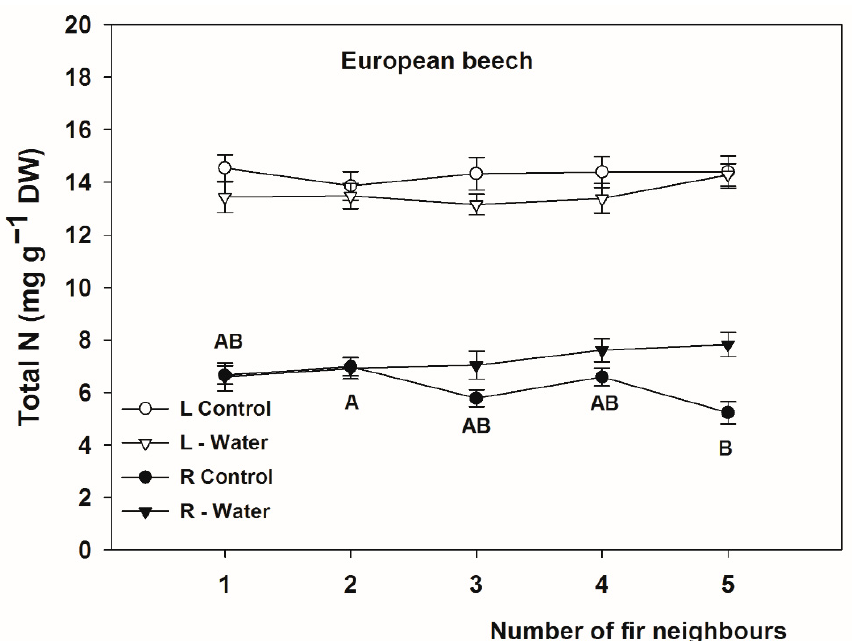
Figure 4. Total nitrogen (N) content of European beech after two years of growth in mixed cultivation with silver fir as dependent on the number of fir neighbors. -Water: Beech/fir mixtures exposed water deprivation and rewatering during the first year of growth. L: leaves, R: roots. Data shown are means ± SD ( n = 15–16). Significant differences ( p < 0.05) between the number of neighbors are indicated by different capital letters.